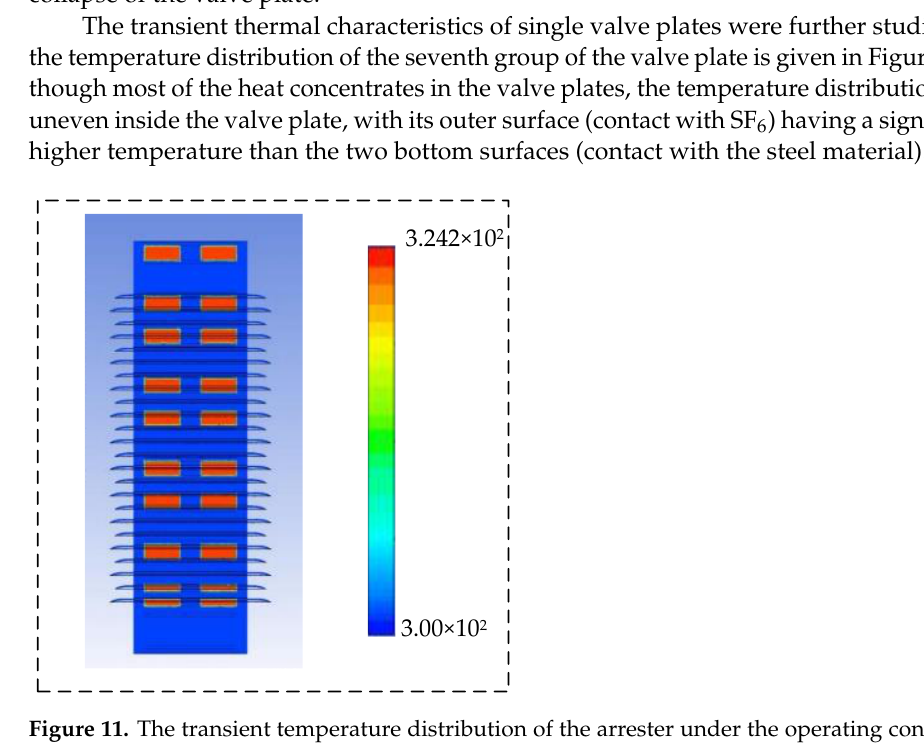
Figure 10. Single arrester power curve under the fault f18.